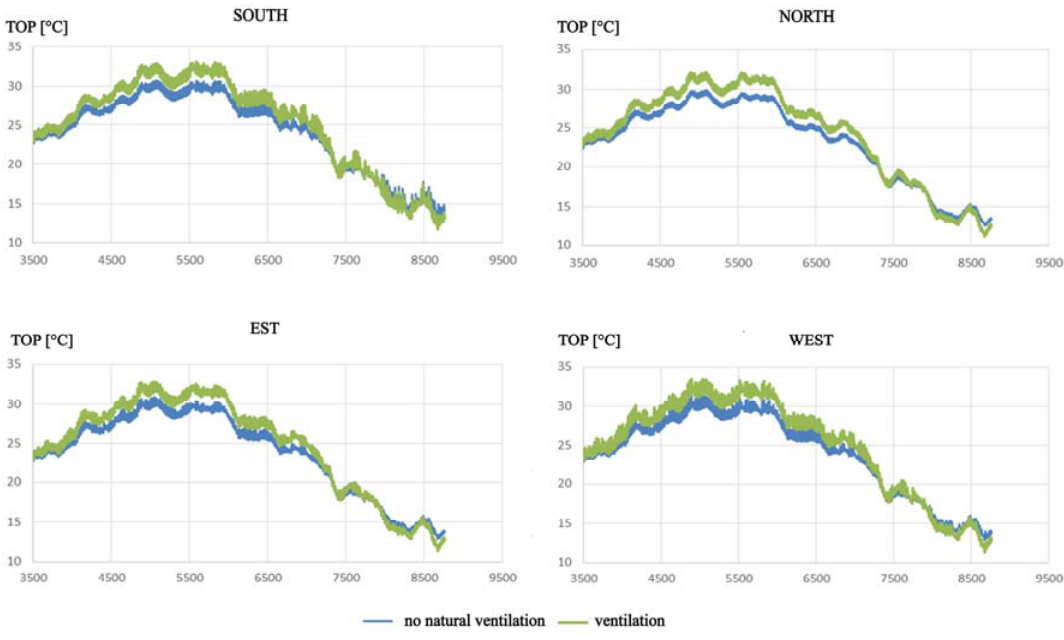
Figure 13. Comparison of Combo 17 performance with and without ventilation.